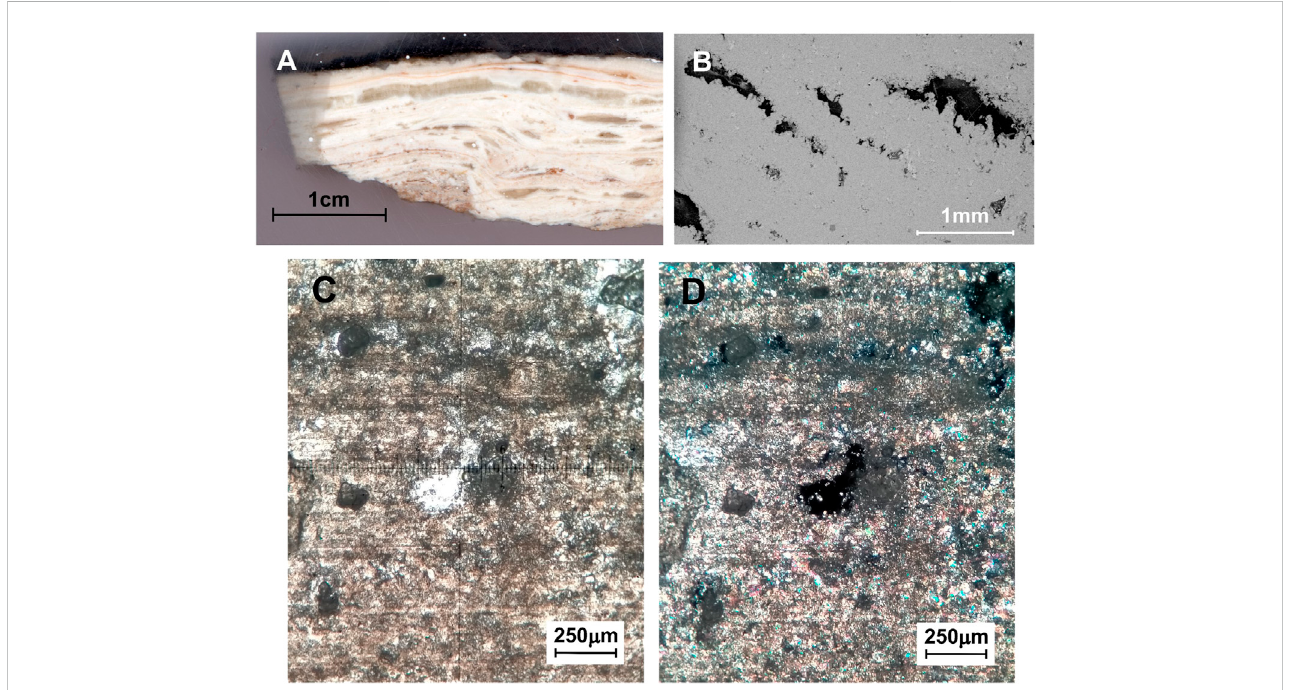
FIGURE 9 Paper-thinrafttravertine. (A) Polishedslabofpaper-thinrafttravertine. (B) SEMimageshowingthegrowthofcalcitecrystalsinbandsseparatedbypores with crystalline regrowth at their boundaries (C and D) Thin section with parallel and crossed nicols respectively. In the microscopic images, we have micritic cores of paper-thin rafts embedded with scattered calcite